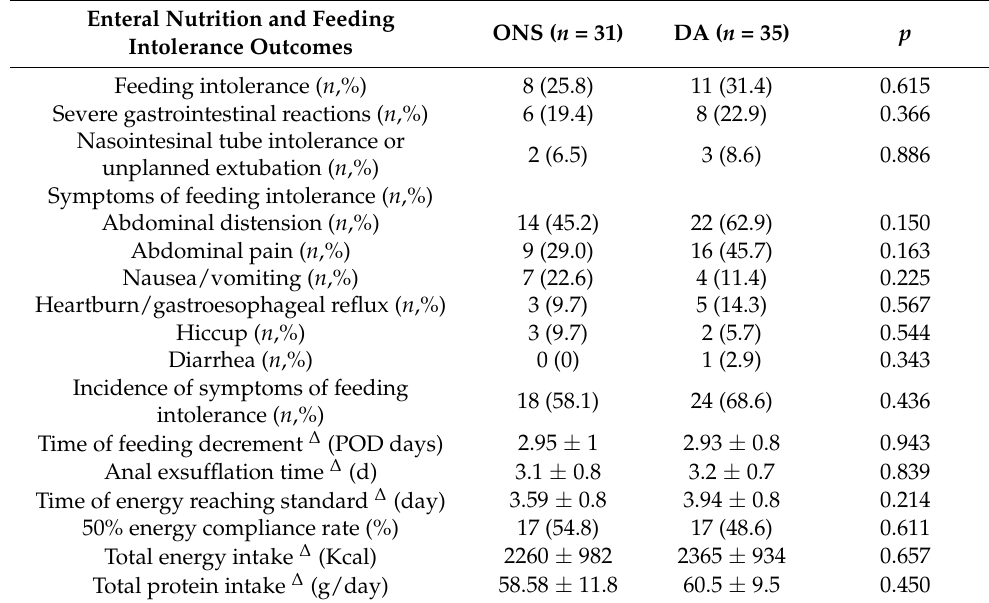
Table 2. The study